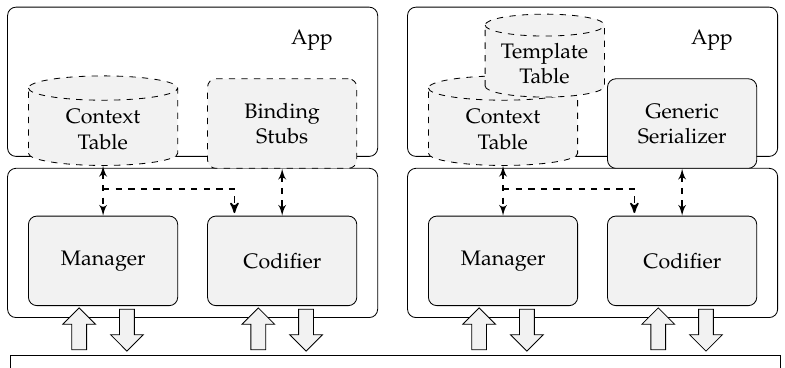
Figure 9. Architecture of the CTC Library . Dotted components are generated by the CTC Compiler